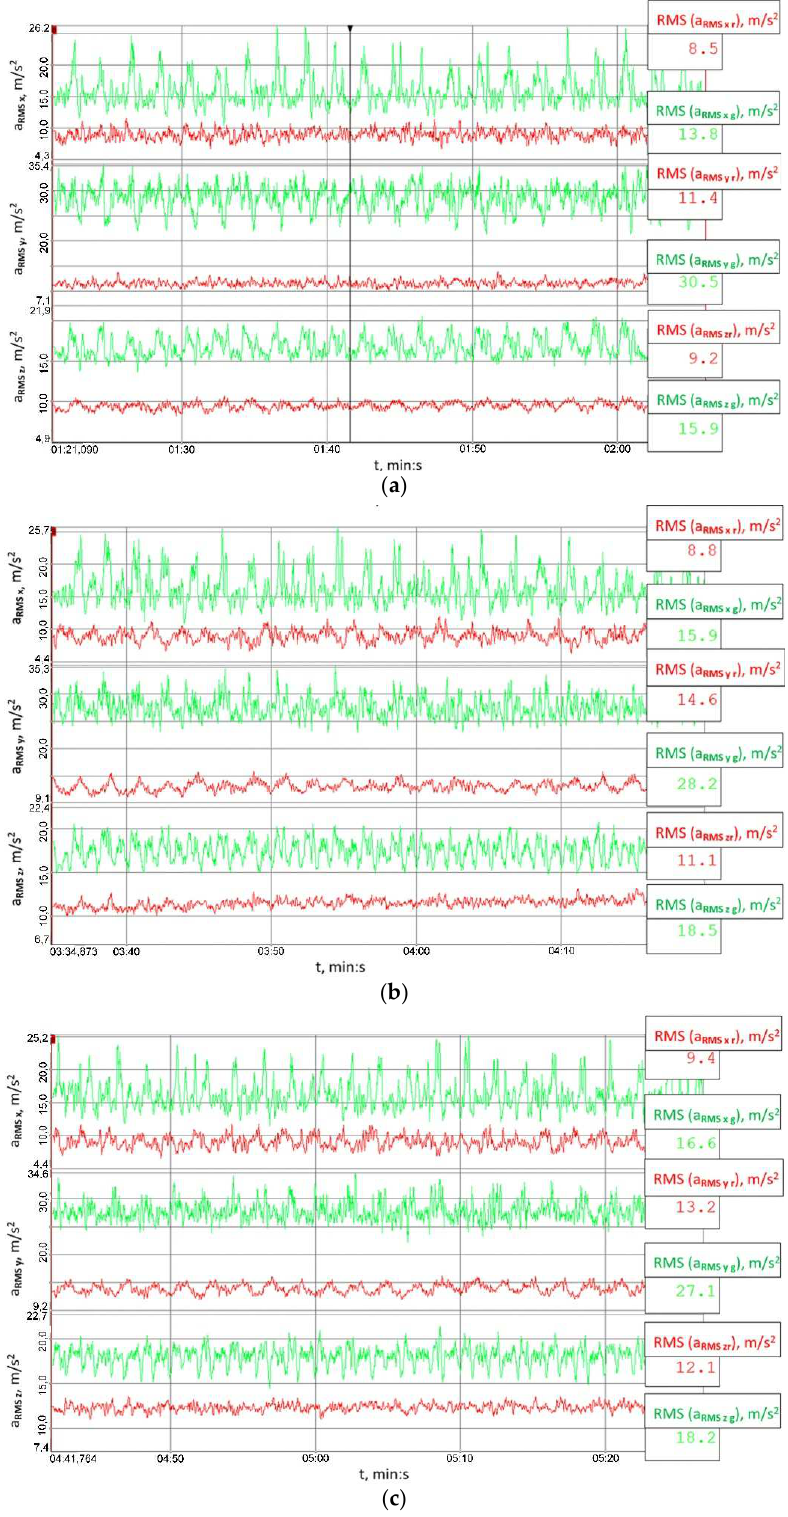
Figure 14. Behaviour of the RMS values of the signals recorded at the output shaft housing in the multi-stage reduction gear (point 14519) established within a time window moved along the time axis: ( a ) 41.8 ± 27.9 Nm, ( b ) 79.2 ± 55 Nm, ( c ) 114.8 ± 75.9 Nm; red colour marks the results obtained for the flexible operation mode of the clutch; green colour corresponds to the locked operation